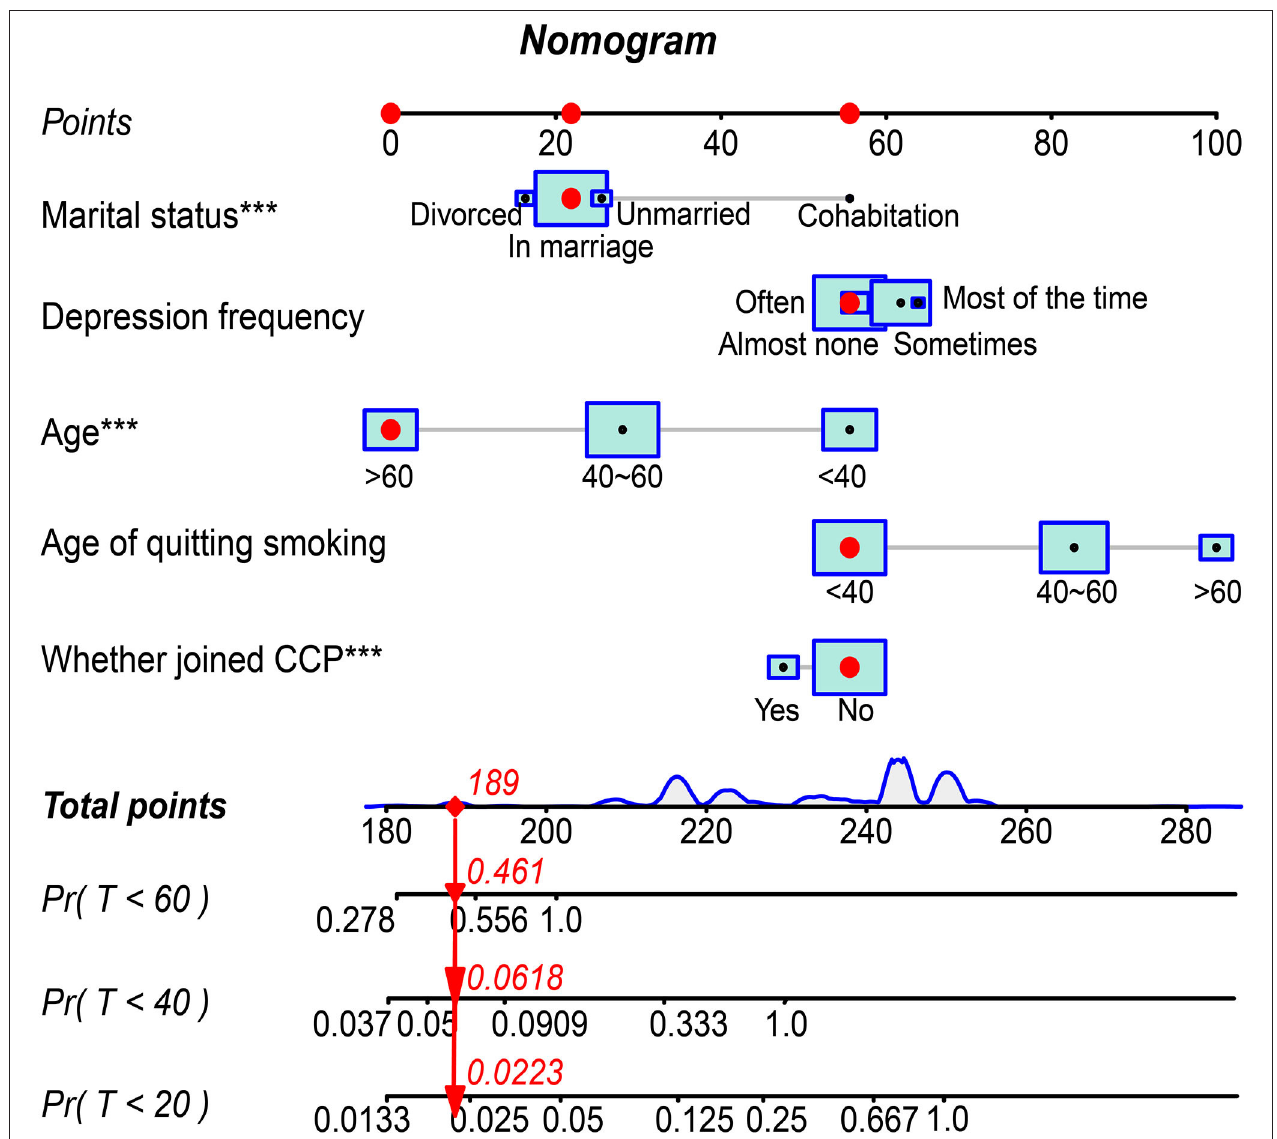
FIGURE 3 | Interactive Nomogram visualizing the cumulative incidence of relapse at 20th, 40th, and 60th years in the competitive risk